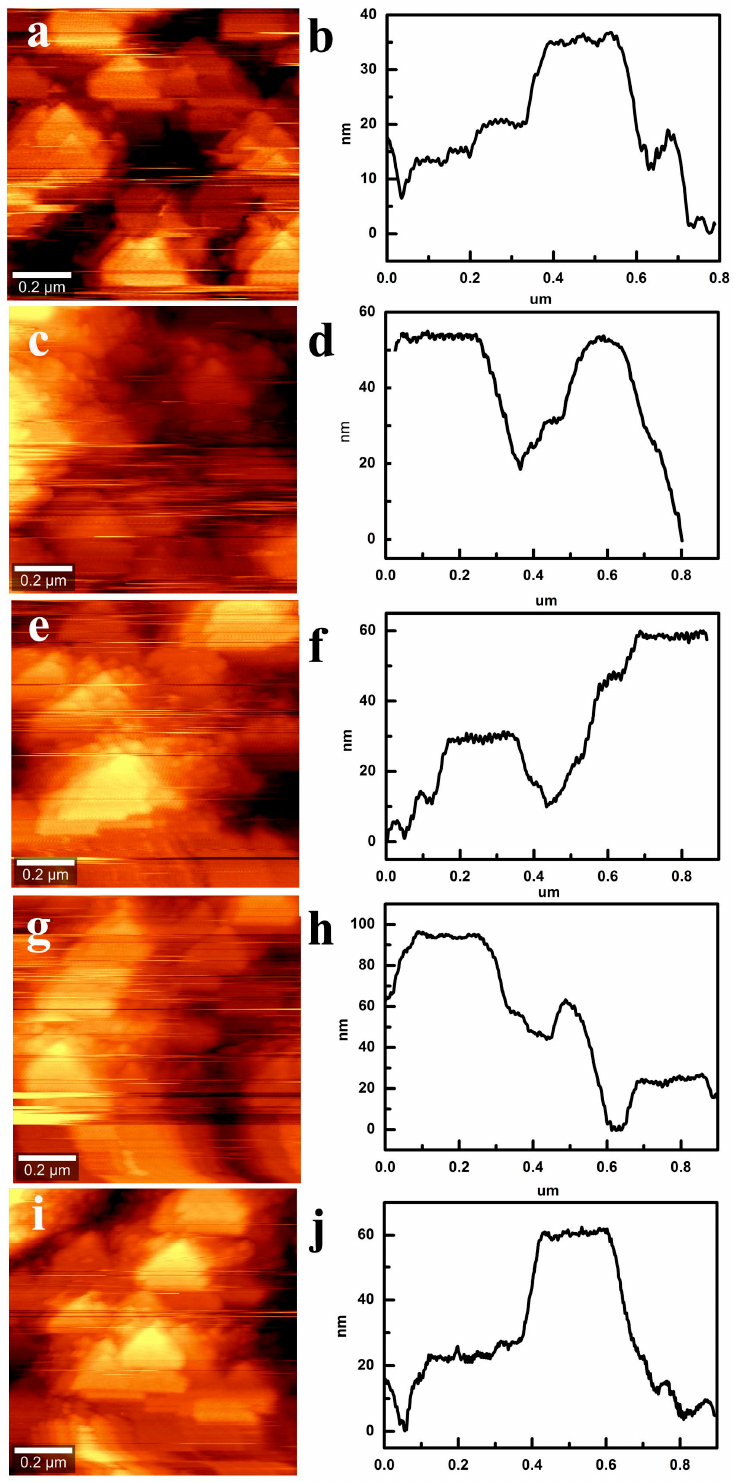
Figure 8. AFM of CS films with different layers: ( a , b ) the first-layer CS film; ( c , d ) the second-layer CS film; ( e , f ) the third-layer CS film; ( g , h ) the fourth-layer CS film; ( i , j ) the fifth-layer CS film.